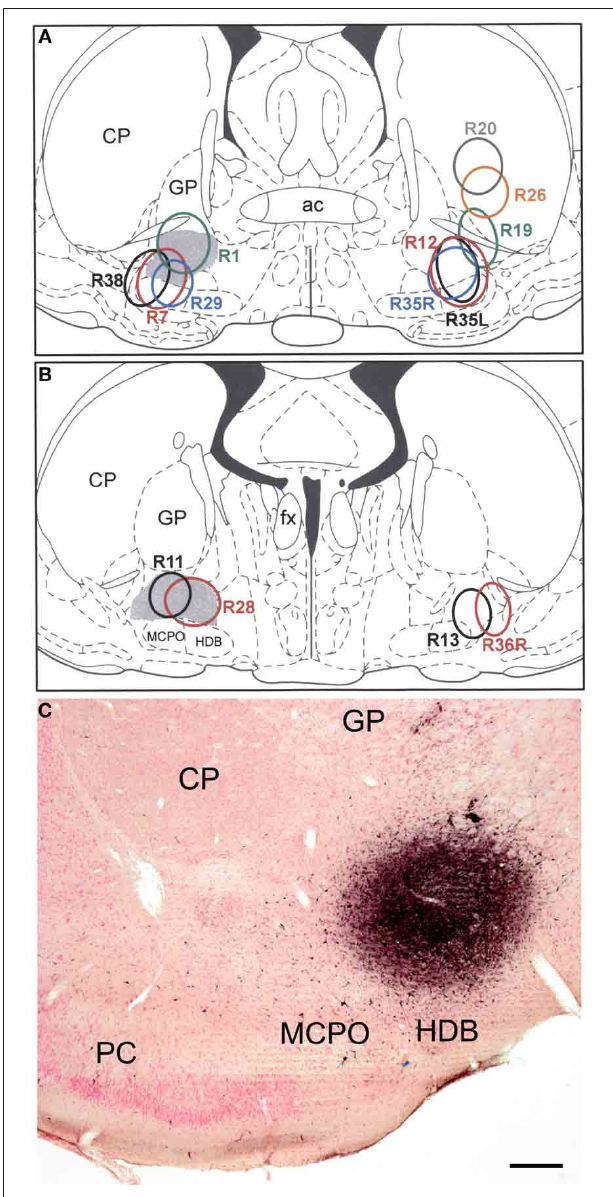
FIGURE 1 | (A and B) Drawings showing the FG injection sites into the BF (and overlying striatum) plotted at the Bregma − 0.3 (A) and Bregma − 0.8 (B) levels of the atlas by Paxinos and Watson (1997). Gray shading indicates the SI/VP portion of the BF, the main source of the cholinergic innervation of the amygdala. Injections in rats whose brains were processed for triple-labeling immunofluorescence (FG/SOM/NPY and FG/SOM/CB) are depicted on the left. Injections in rats whose brains were processed for double-labeling immunofluorescence (FG/SOM, FG/PV, and FG/CR) are depicted on the right. The letters “L” (left) and “R” (right) in three of the case numbers (R35L, R35R, R36R) indicate whether the injection site in these three bilaterally injected rats was on the left or right side. (C) Photomicrograph of the injection site in case R28. This section was counterstained with pyronin Y (a pink Nissl stain). Left is lateral. Abbreviations: ac, anterior commissure; CP, caudate-putamen; fx, fornix; GP, globus pallidus; HDB, horizontal limb of the nucleus of the diagonal band; MCPO, magnocellular preoptic nucleus; PC, piriform cortex. Scale bar in C = 250 µ